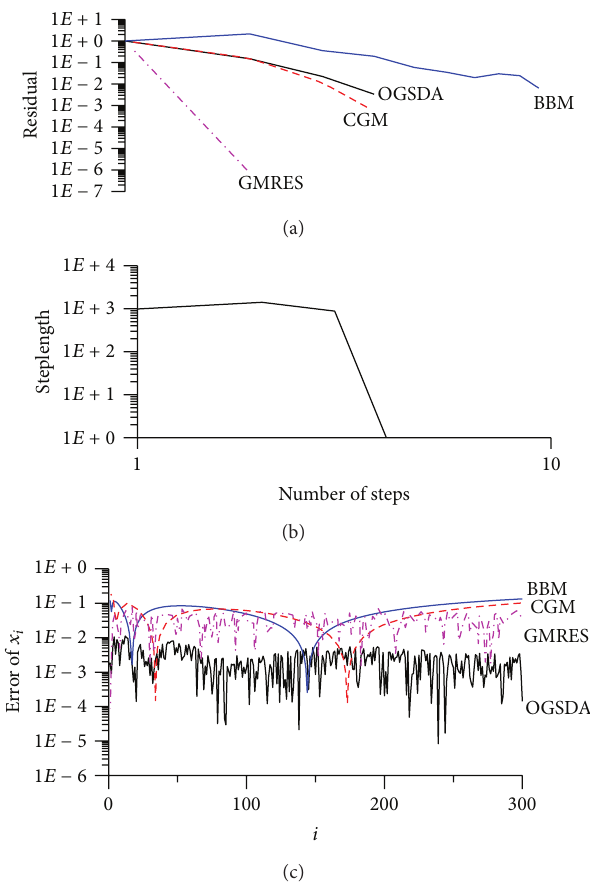
Figure 3: Example 2 of the Hilbert problem with 𝑛 = 300 , showing (a) relative residuals, (b) steplength of OGSDA, and (c) comparing the numerical errors of CGM, GMRES, OGSDA, and